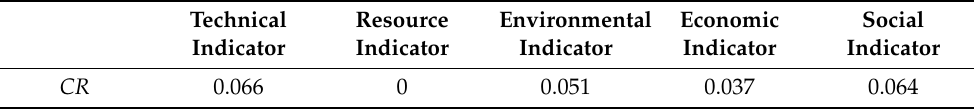
Table 11. Consistency ratio of five